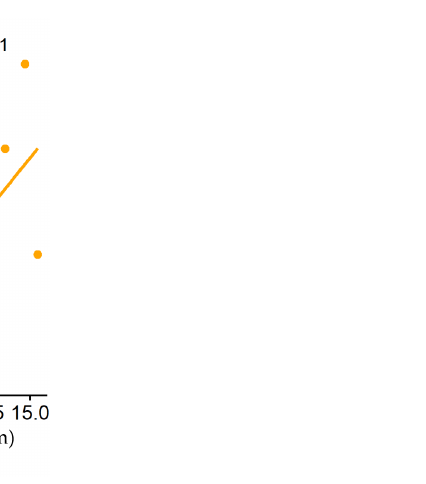
Figure 4. The relationship between tambaqui ( A ) IB number and ( B ) length in dissection and X‑ray imaging methods (R Pearson, p < 0.001).